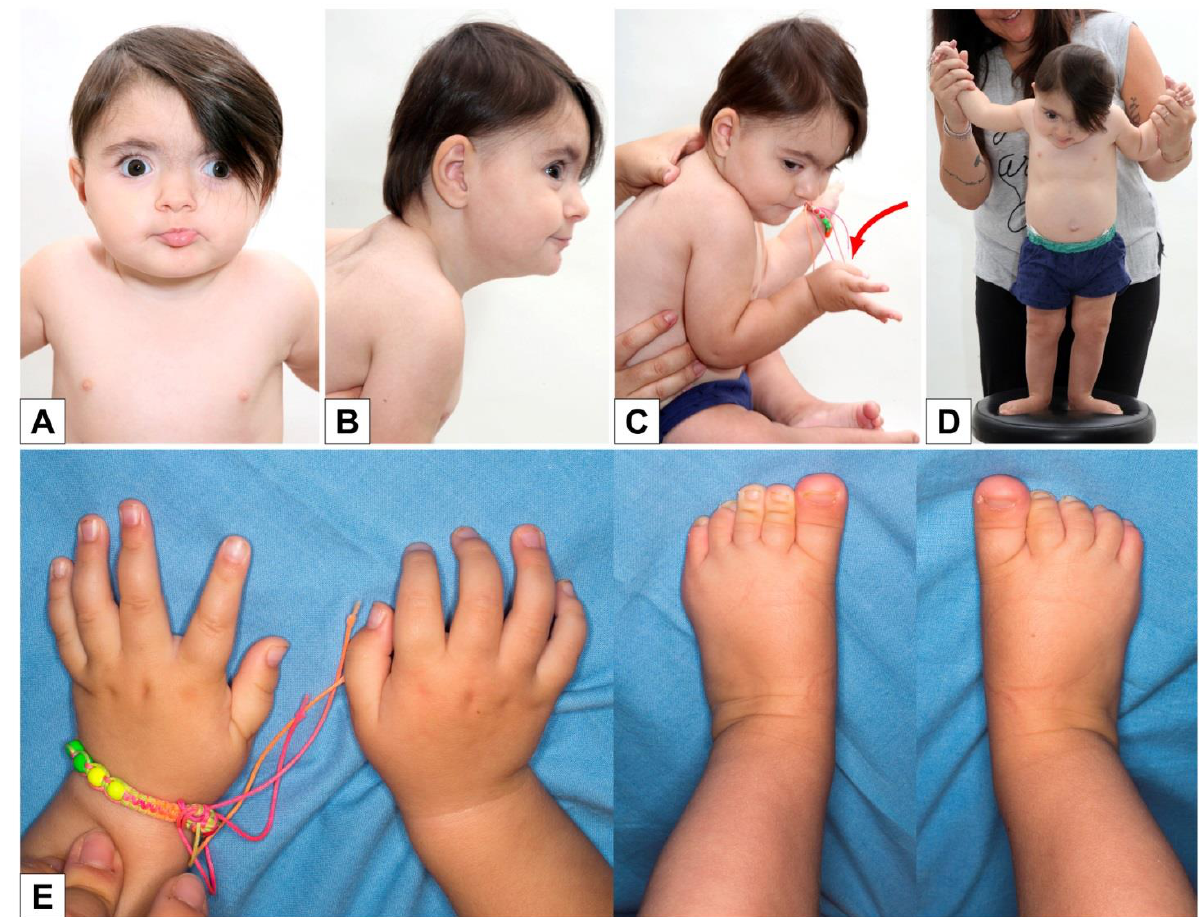
Figure 2. Clinical features at 17 months: facial dysmorphism ( A , B ), flattening of the occiput ( B ), adducted thumb and long first toe bilaterally ( C – E ), standing/walking with support ( D ).